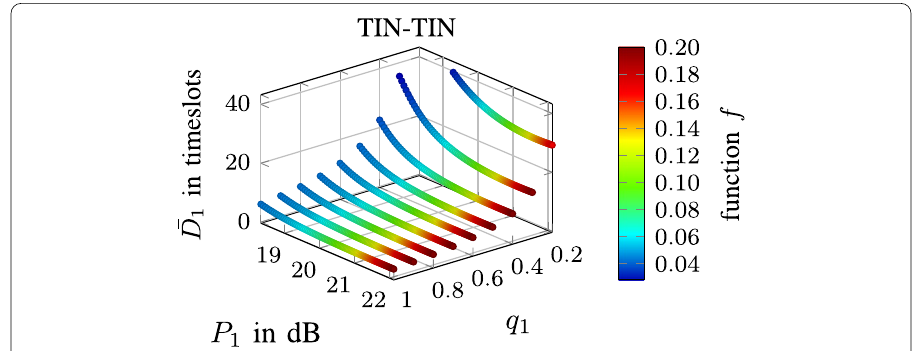
Fig. 3 ( ¯ D 1 , function f aw ) vs. ( q 1 , P 1 ), under congestion-aware randomized policy in TIN-TIN. The rest of the parameters are the following: (cid:31) 1 = 0.1 , γ 1 = − 4.2dB , γ 2 = − 6.4dB , α = 2.2 , β = 41dB , P J = 23dB , q 2 = 0.4 , B = 6 packets, P max = 23dB , d 2 = 14.6m , and d 12 = 10m . In TIN-TIN, d 1 =